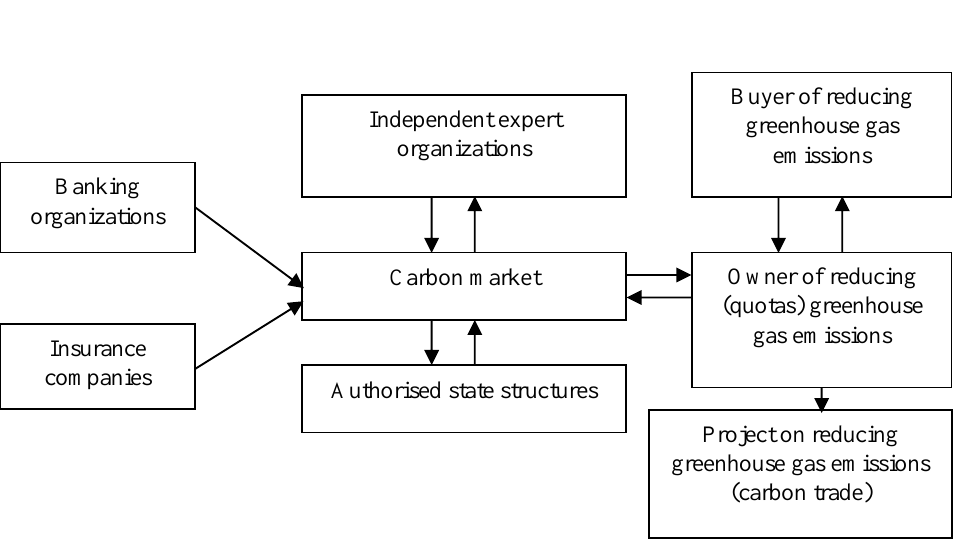
Fig. 1. Scheme of stakeholders’ interaction in the implementation of projects to reduce greenhouse gas